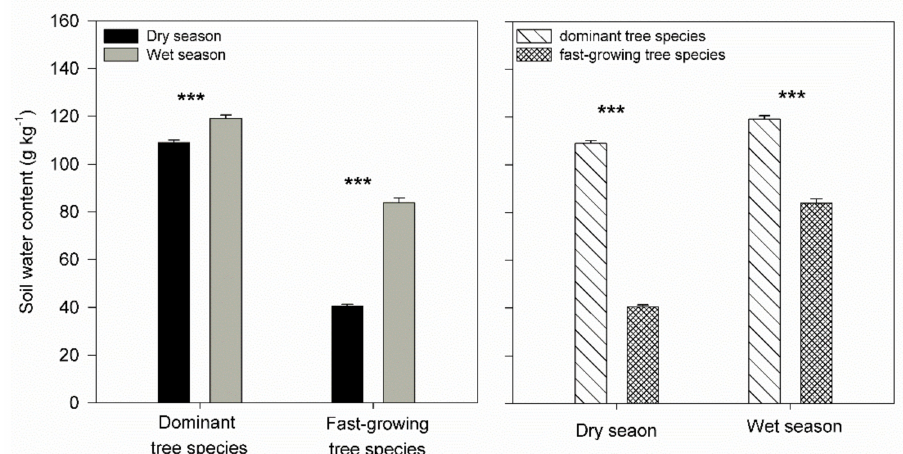
Figure 5. Di ff erences in the soil water contents of reforested area and its adjacent undisturbed tropical rainforest ecosystem in the wet and the dry seasons. *** indicates p < 0.05 and NS (nonsignificant) indicates p > 0.05 based on generalized linear mixed e ff ect model with Poisson error family. Bars indicate the mean values, and error bars denote standard